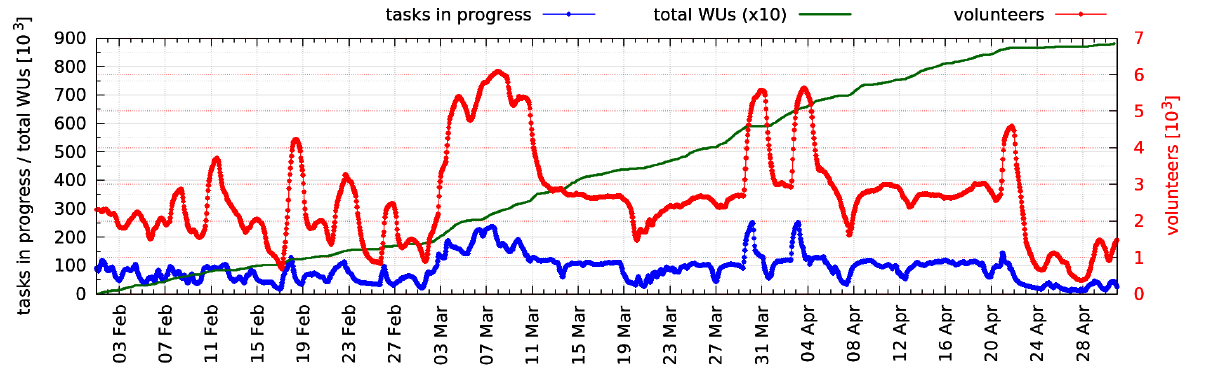
Figure 1: Time evolution of the cumulative number of WUs, volunteers, and tasks sent to BOINC from Feb. 2017. preservation tool [19]. The results are stored as histograms and reference plots, in the on-line MCPlots database [11], which is available to the global particle-physics commu- nity. It is used by both the authors of the simulations and by their users, as a validation tool, and to guide further ef- parameters (see e.g.